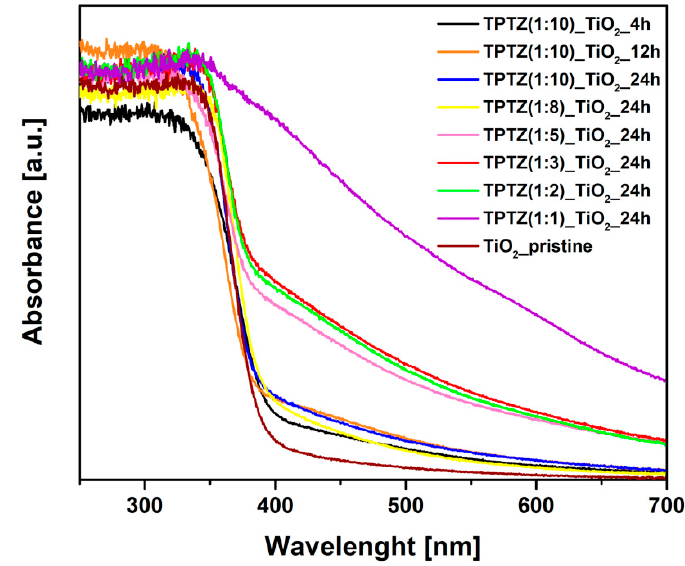
Figure 6. Time-dependent and IL content-dependent changes in the UV-VIS absorption of TPTZ_TiO 2 microparticles.